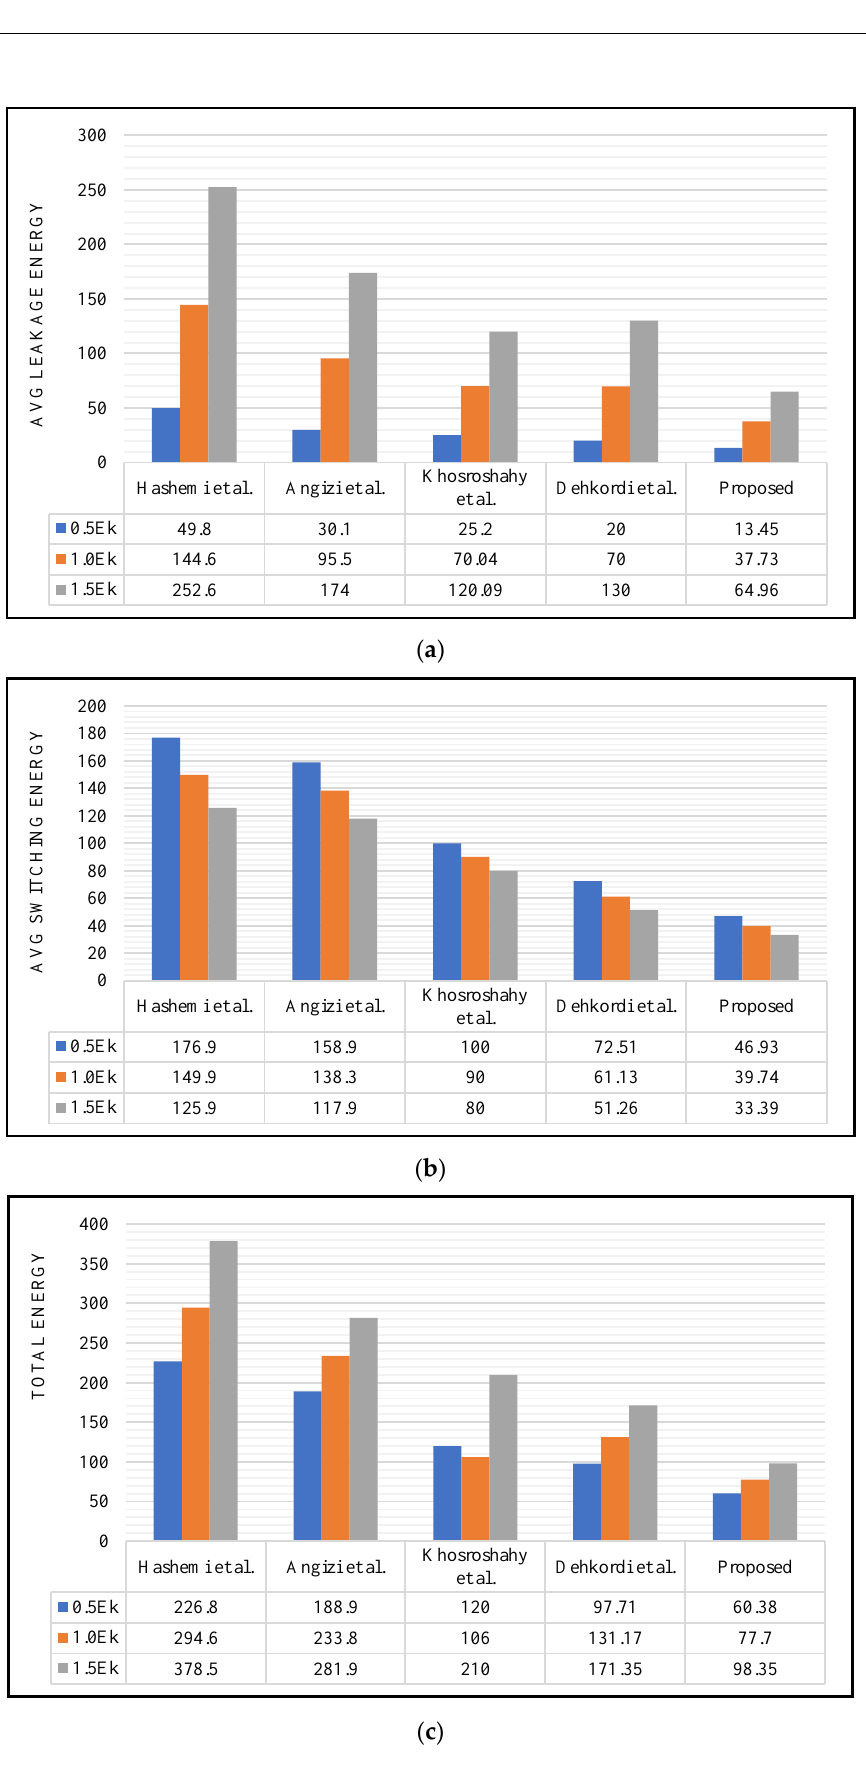
Figure 7. Graphical comparison of ( a ) average leakage, ( b ) average switching dissipation, and ( c ) total energy dissipation (meV) of the memory cell at different kink energy levels with designs Hashemi et al. [31], Angizi et al. [30], Khosroshahy et al. [26], Dehkordi et al.